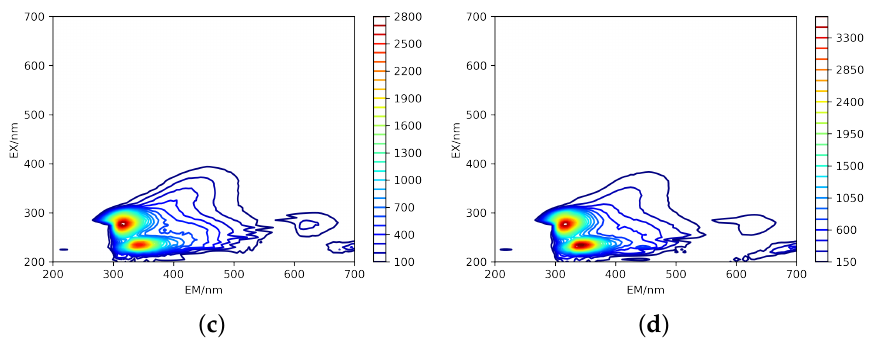
Figure 10. Drinking water spectra for ( a ) day 1, ( b ) day 2, ( c ) day 3, ( d ) day 4.